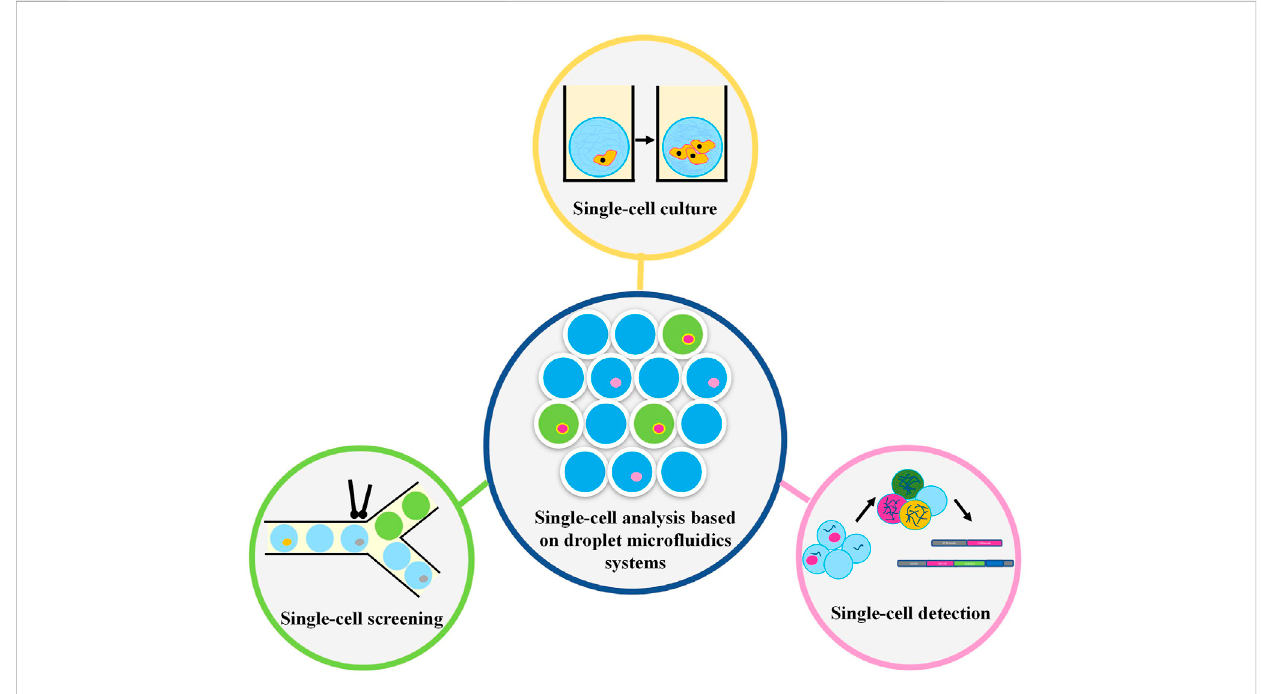
FIGURE 1 The single-cell analysis based on droplet micro fl uidics